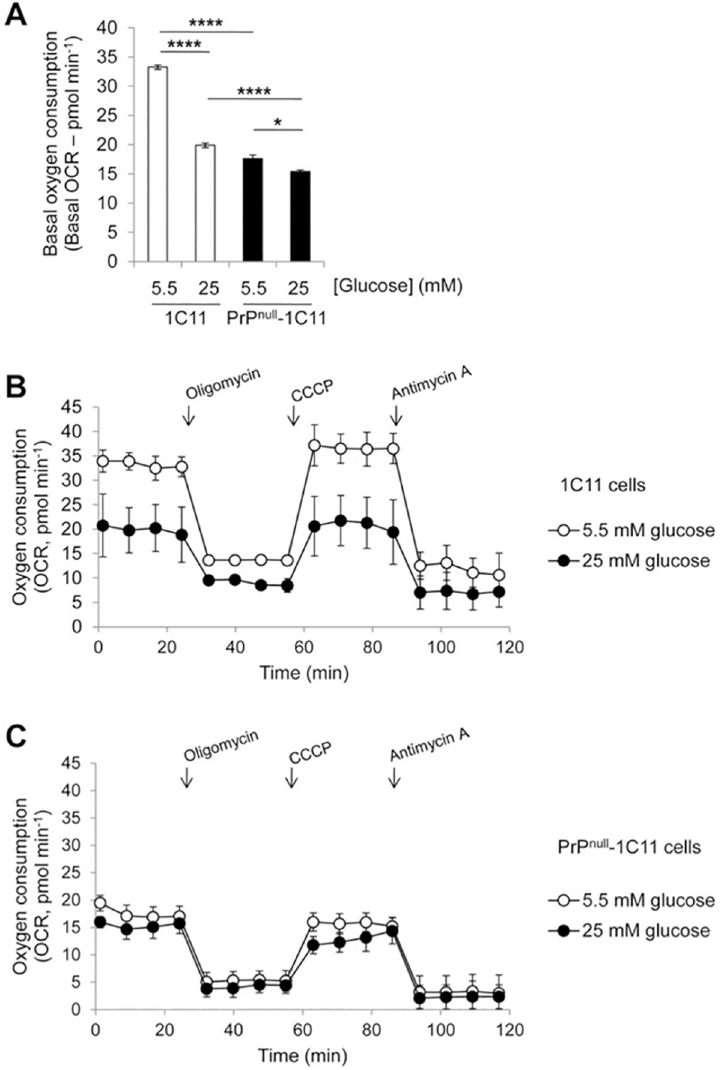
Fig 3. PrP C depletion in 1C11 cells reduces mitochondrial oxygen consumption. ( A ) Comparison of basal oxygen consumption rate (OCR) between 1C11 and PrP null -1C11 cells grown in DMEM containing 5.5 or 25 mM glucose using a Seahorse XF e 96 Extracellular Flux Analyzer (n = 6). Values are the mean fold change ± SEM. ( B, C ) Mitochondrial respiration profile of 1C11 cells ( B ) and PrP null -1C11 cells ( C ) grown in a medium containing 5.5 or 25 mM glucose. The OCR was measured before and after the sequential addition of oligomycin (10 mg ml -1 ), CCCP (5 μ M), and antimycin A (10 μ M) for 120 min. Values are the average of 6 replicates ± SEM. � denotes p < 0.05 and ���� p <